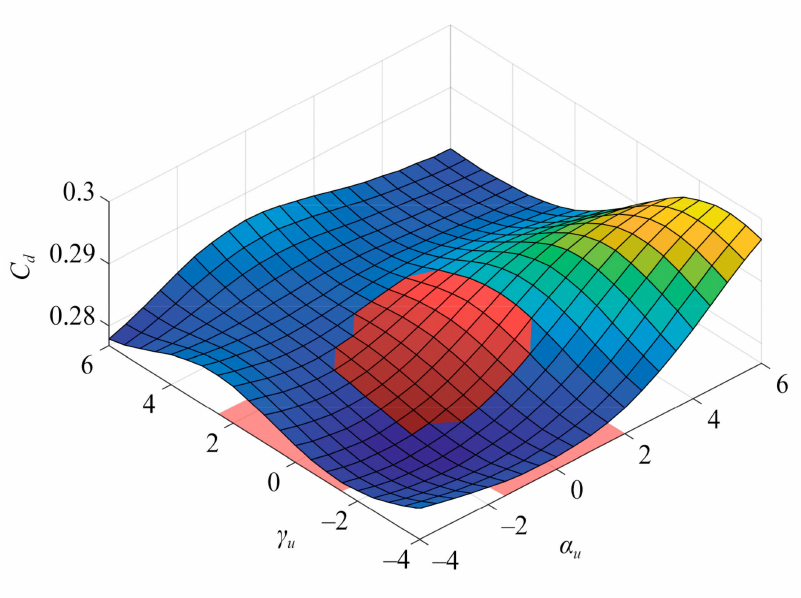
Figure 15. The e ff ect of α u , γ u ∈ 1 ± 5 on C d when α v = γ v =